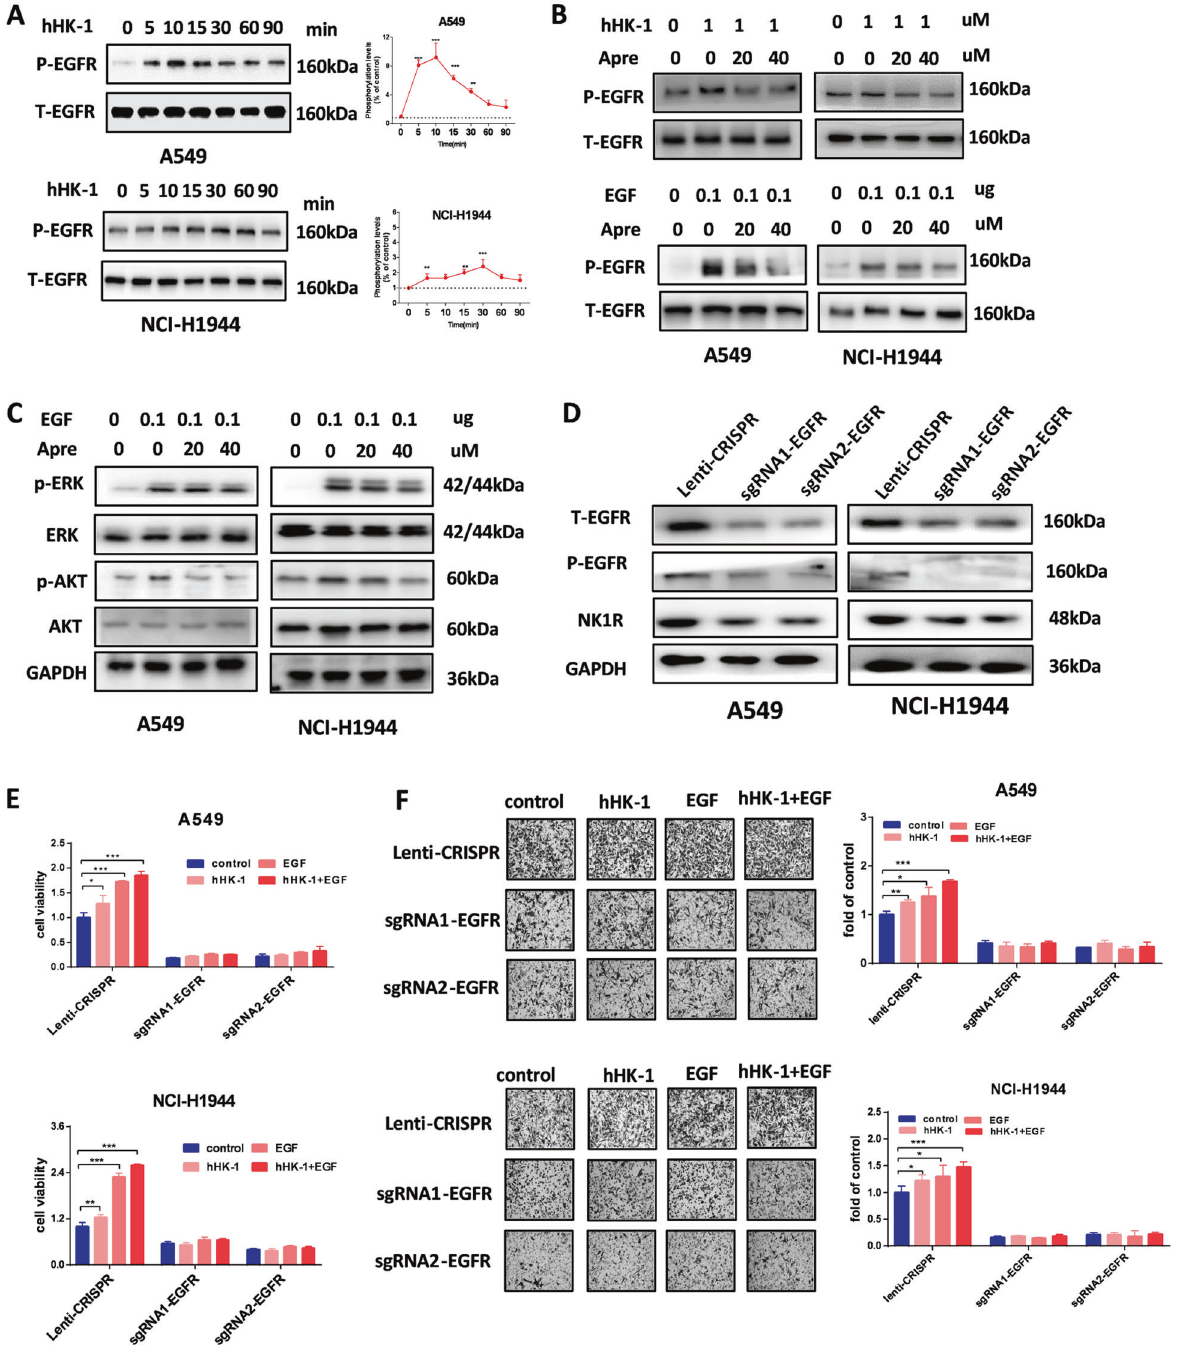
Fig. 7 NK1R transactivates EGFR in NSCLC cells. A Activation of NK1R by hHK-1 transactivated phosphorylation of EGFR (pY1068). Cells were treated by 1 μ M hHK-1 in indicated time after starving 2 h. B Aprepitant inhibited the phosphorylation of EGFR stimulated by 1 μ M hHK-1 or by 0.1 μ g EGF treatment. Total EGFR protein was used as loading control. C Aprepitant inhibited ERK1/2 and AKT phosphorylation induced by EGF. Total ERK and Akt protein were used as loading control. D Total or phosphorylated EGFR and NK1R expression in cells transfected with lenti-CRISPR sgRNA target to EGFR by western blot. E Cell proliferation in EGFR knockout cells with or without hHK-1/EGF treatment for 72 h (Celltiter-Glo assay). F Transwell assay for cell migration in EGFR konckout cells with or without hHK-1/EGF treatment. Data were shown as mean ± SD from three independent experiments. * P < 0.05, ** P < 0.01, *** P < of ERK1/2 and Akt. Furthermore, NK1R activation can increase the to clinical classi fi cation. In stage I and II NSCLC patients, NK1R proliferation, migration as well as promote EMT process in NSCLC expression level was associated with poor prognosis. Notably, NK1R cells. These effects are abolished by either shRNA-mediated is co-expressed with EGFR in NSCLC patient tissues and cells. NK1R downregulation of NK1R expression or the selective antagonist of can interact and regulate EGFR signaling, inducing EGFR phosphor- NK1R aprepitant. Importantly, NK1R antagonist induced apoptosis in ylation as well as an enhancement of intracellular signaling activities